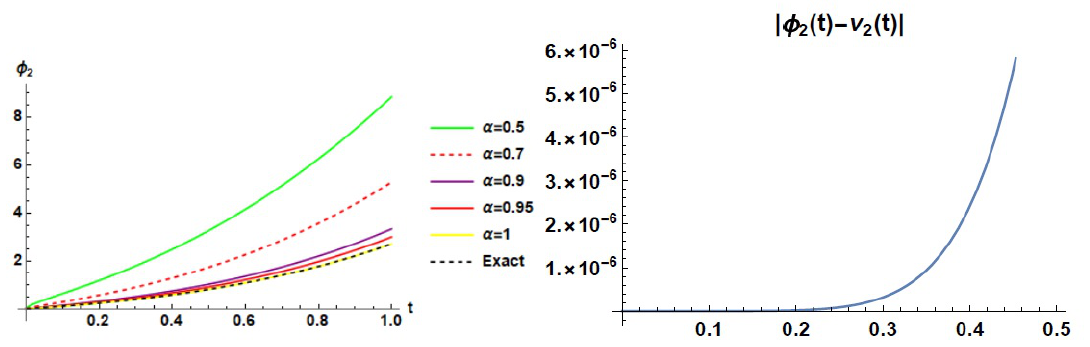
Figure 2: Exact, profile approximate solutions and absolute error regarding ν 2 of Example 1.